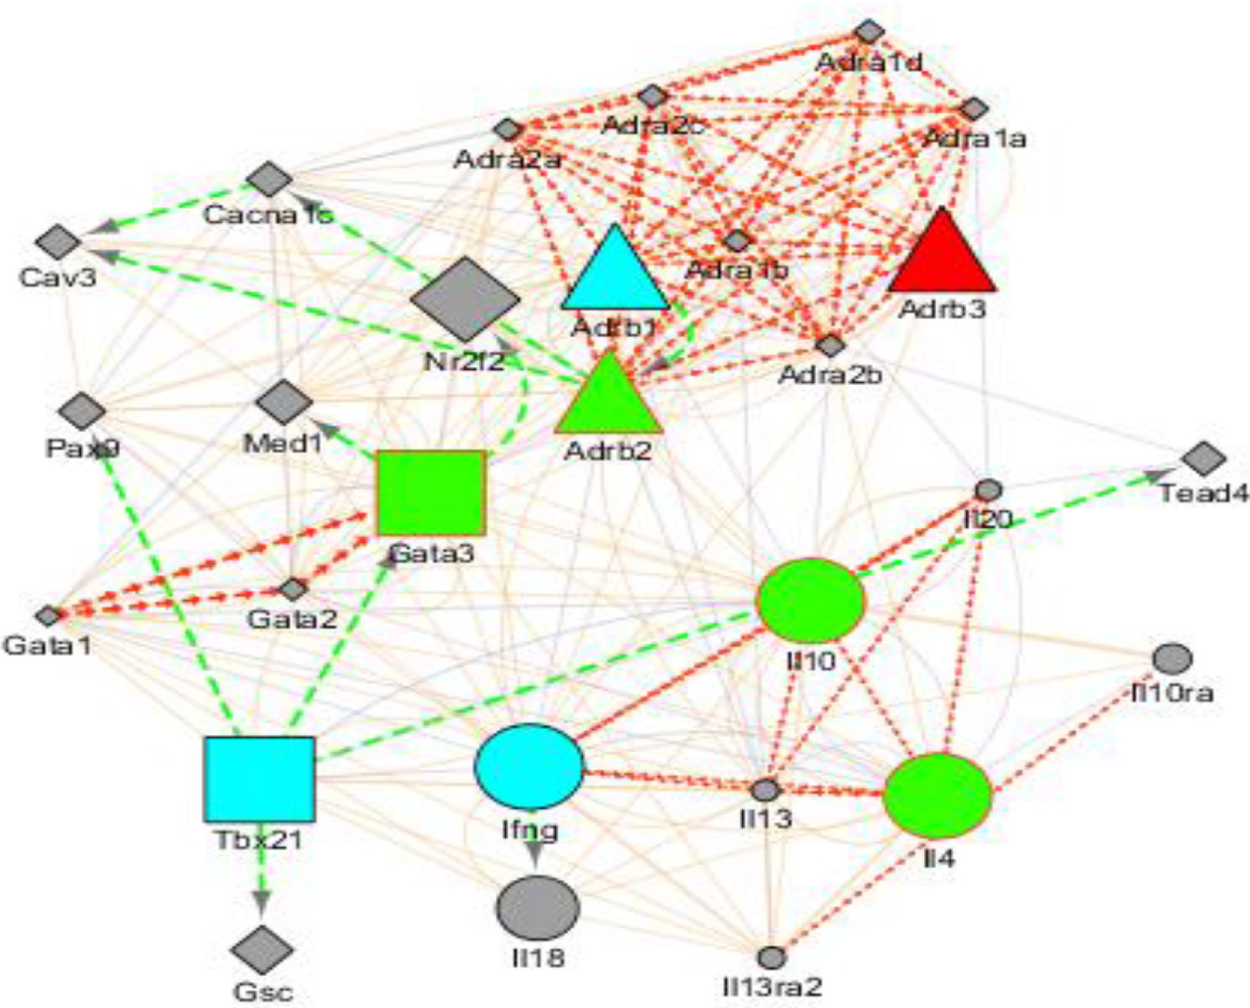
Fig 11. Cystoscope image of functional gene expression and potential regulation during C . muridarum genital infection in mice. The color of the nodes shows up- or down-regulation of genes in stressed mice during C . muridarum genital infection. Nodes shapes are made to show transcription factors, cell signaling receptors, and cytokines. The edges are colored to show nodes that are affected by up-and down-regulation in stressed mice during C . muridarum genital infection.